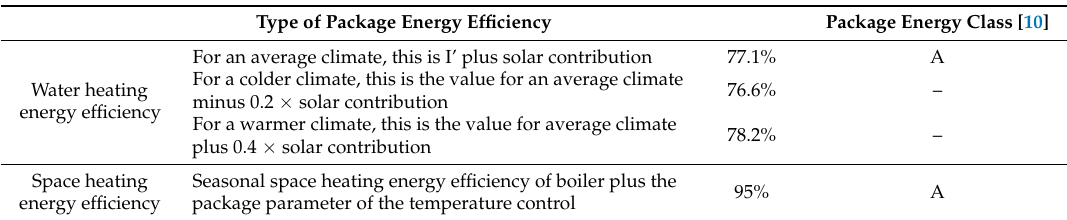
Table 6. Package energy efficiencies and class for the case study.